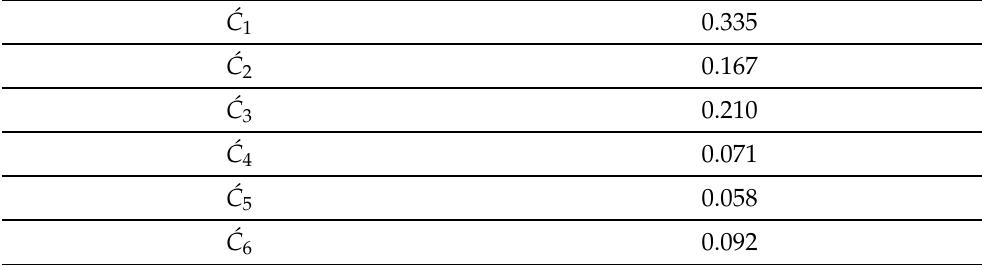
Table 11. Criteria weights.